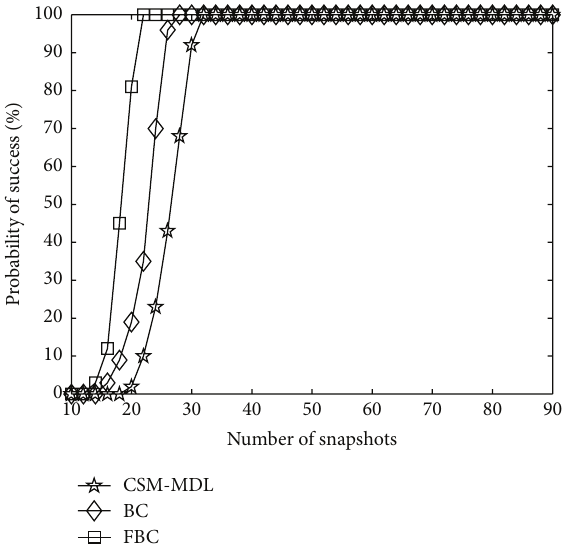
Figure 2: Probability of success versus SNR for uncorrelated signals in Gaussian white noise.